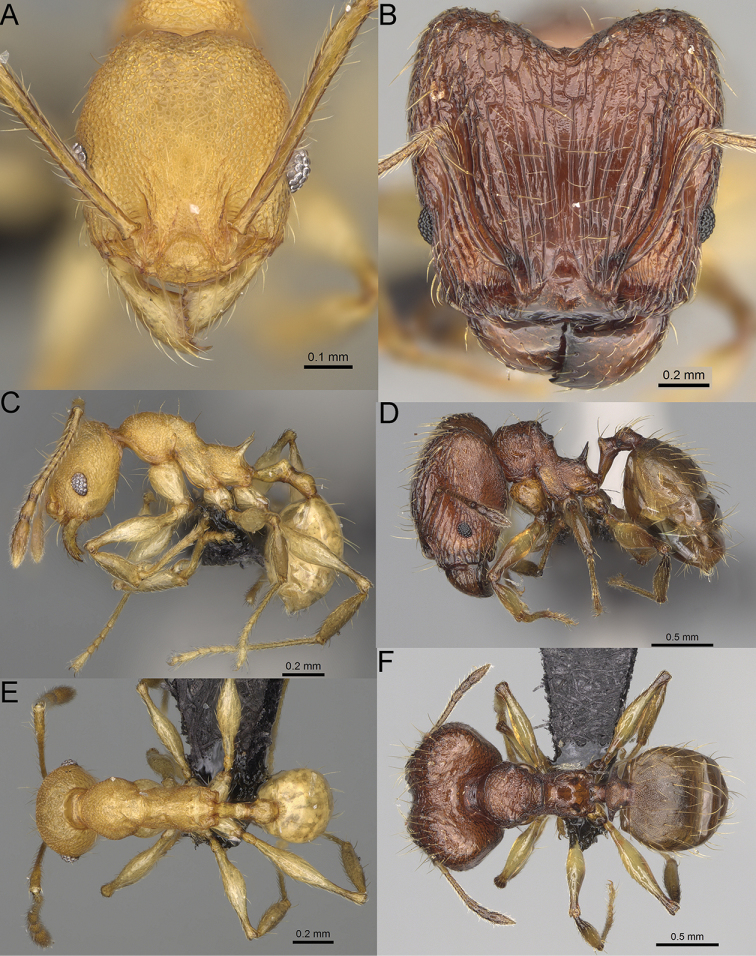
Pheidole
ferruginea sp. nov., full-face view (A), profile (C), and dorsal view (E) of paratypeminor worker (CASENT0494994) and full-face view (B), profile (D), and dorsal view (F) of holotype major worker (CASENT0494997).